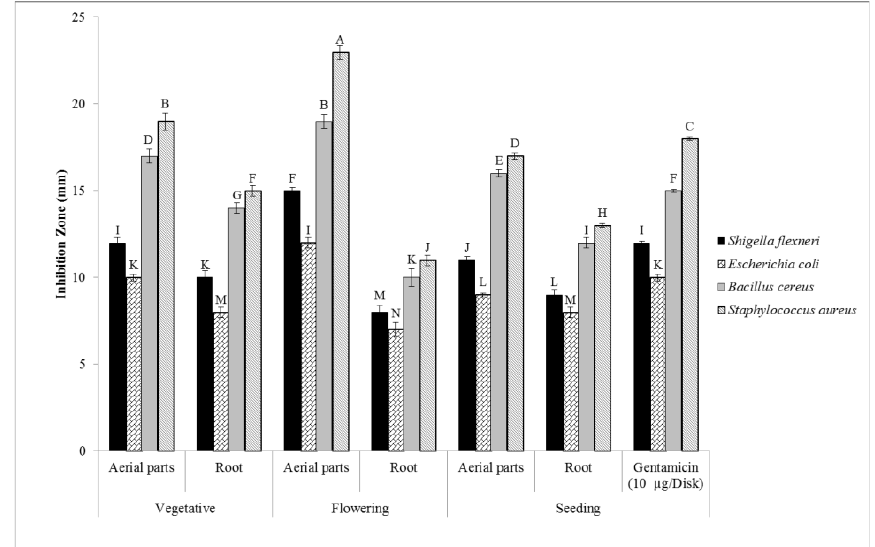
Figure 6. The inhibition zone ( n = 3) of the extracts of the T. polium aerial parts and root at different phenological stages against the Gram-positive ( B. cereus , S. aureus ) and Gram-negative bacteria ( Sh. flexneri , E. coli ) strains. The extract concentration is 200 µg/mL. Various letters indicate statistically significant differences ( p < 0.05).